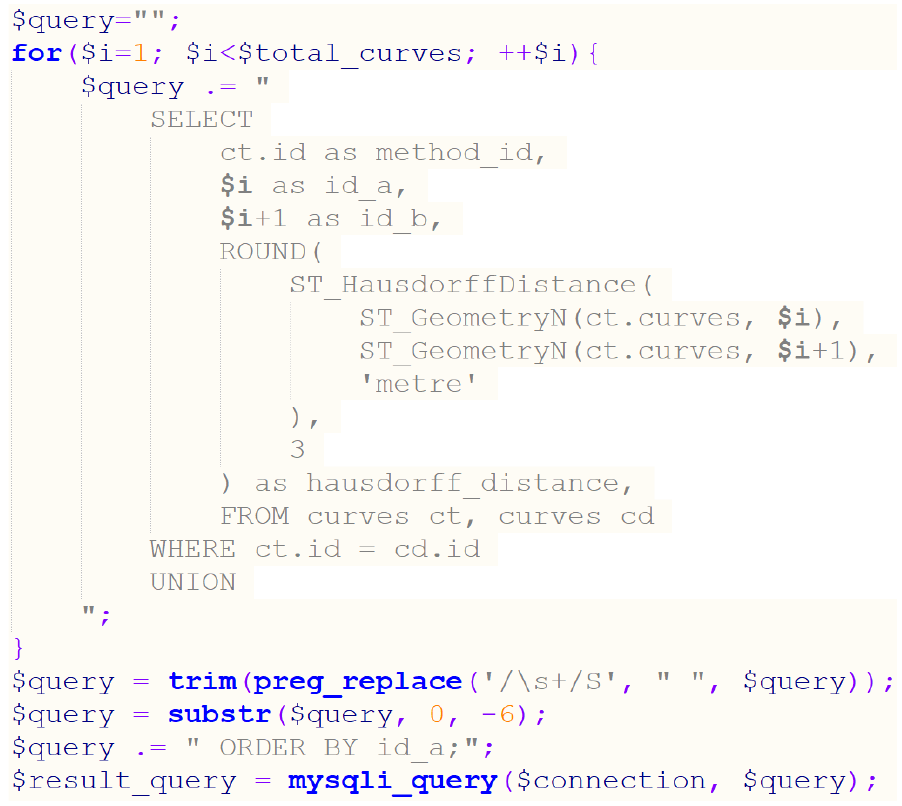
Figure 11. Implementation of the query in PHP and SQL to obtain the Hausdorff distance among features of the same geospatial